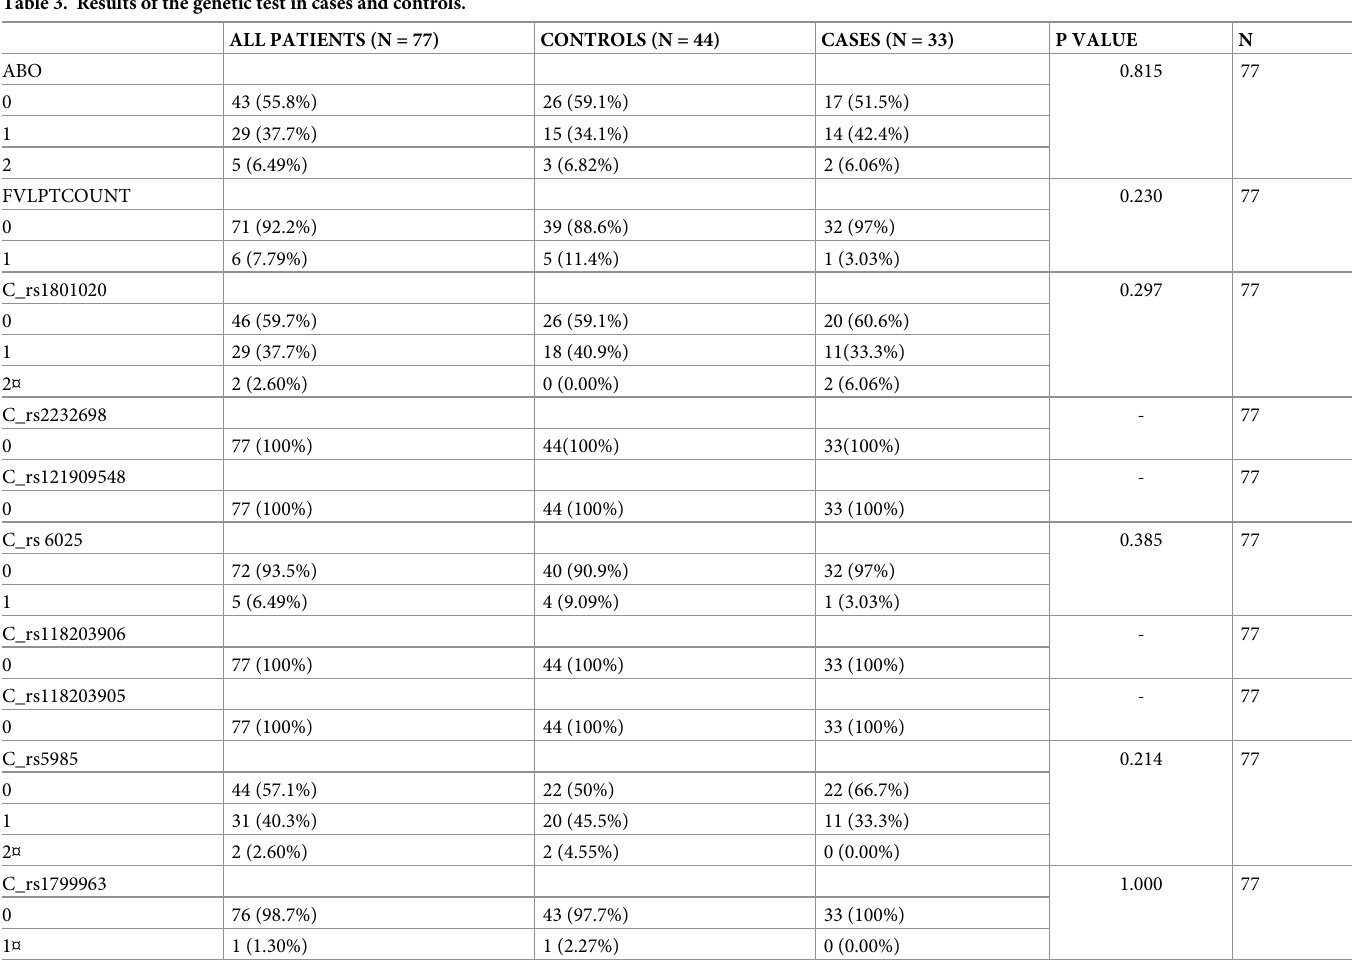
Table 3. Results of the genetic test in cases and controls.